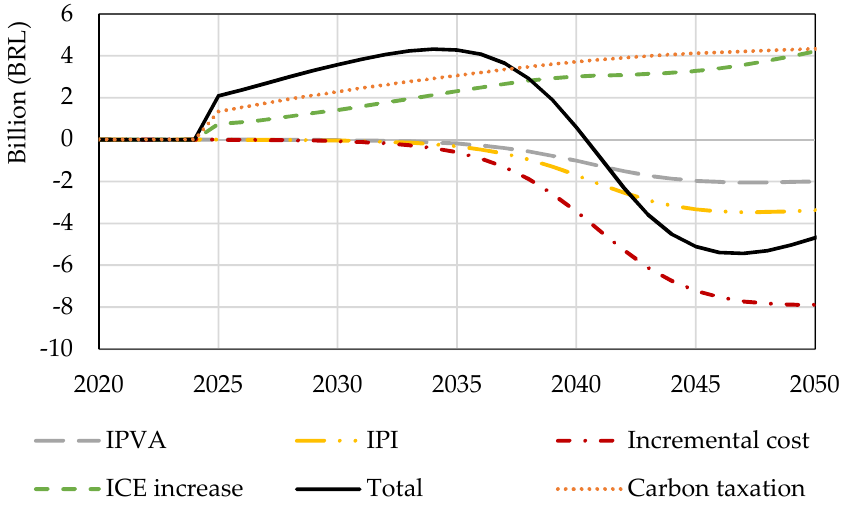
Figure 5. Individual policy revenue in Brazil ( S alt ), 2020 to 2050.